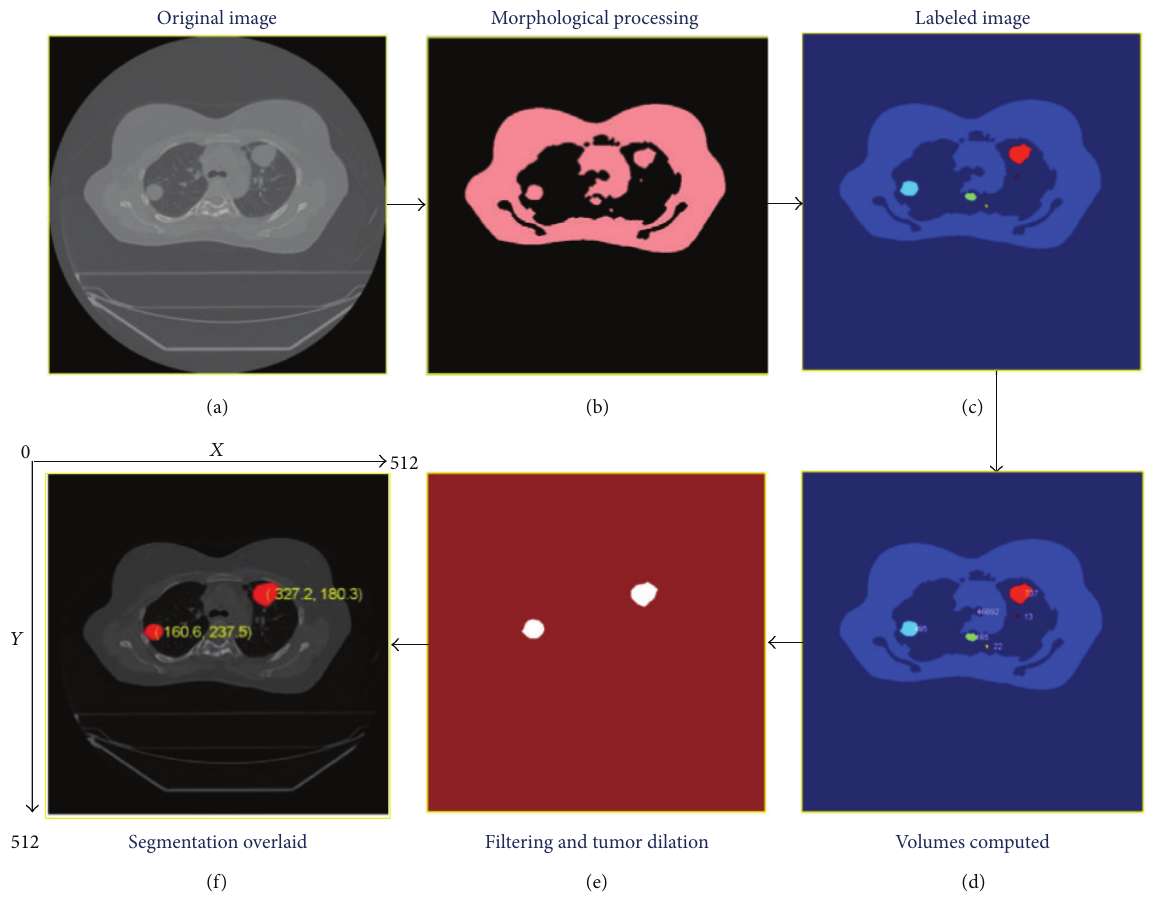
Figure 1: Morphological processing based automated segmentation approach for contouring the tumors. The center of geometry of the segmented tumors is useful for quantifying tumor motion between different